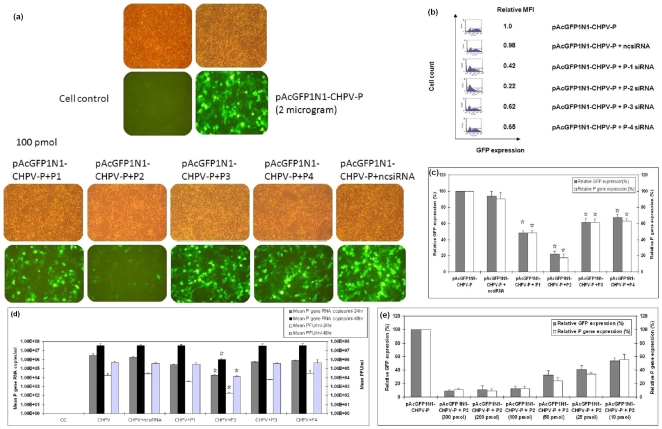
Validation of P gene siRNA using pAcGFP1N1-CHPV-P.(a) Fluorescent microscopic images of HEK-293 cells transfected with different P gene siRNAs and plasmid pAcGFP1N1-CHPV-P. (b) P gene siRNAs validated by flowcytometry at the protein level (c) Reduced expression of P gene mRNA by real time one step RT-PCR. (d) P gene validation with CHPV at different time points. (e) Effect of different doses of P-2 siRNA on the expression of P gene as determined by flowcytometry and real time one step RT-PCR. Result are expressed as means ± SD. * indicates significantly different from control at p <0.05 by Dunnett's test.